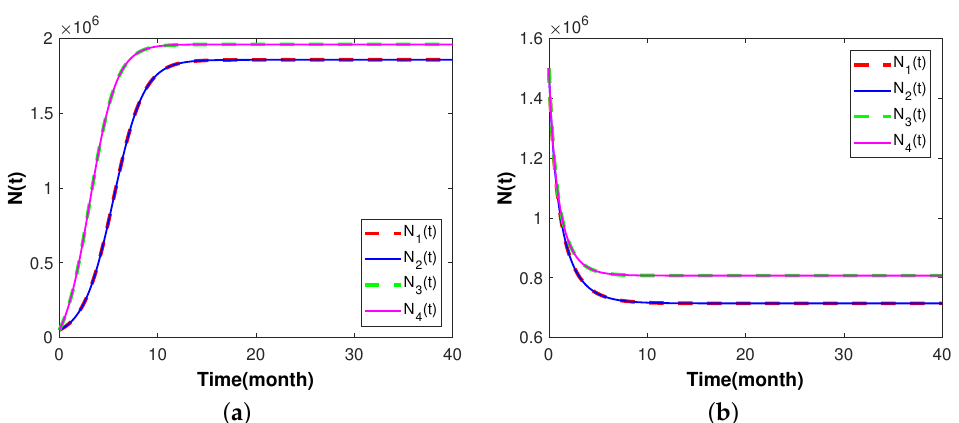
Figure 3. Livestock scale. ( a ) Based on the first group of parameters. ( b ) Based on the second group of parameters.